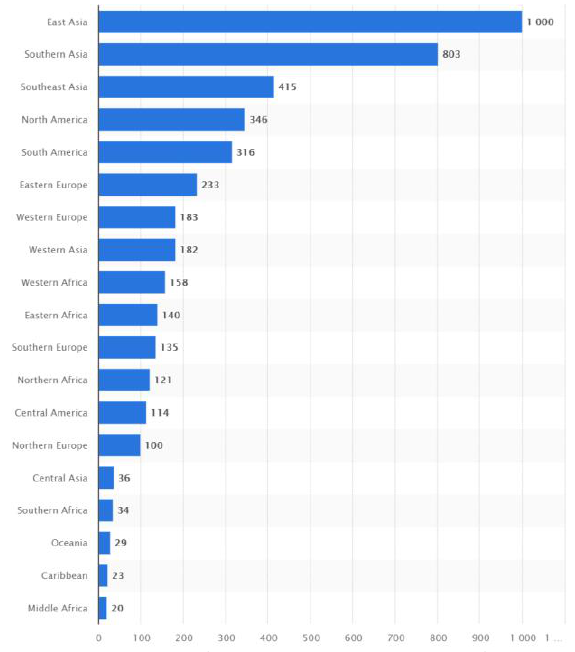
Figure 2: Number of worldwide internet users as of January 2019, by region (in millions) (Source: https://www.statista.com/statistics/249562/number-of-worldwide-